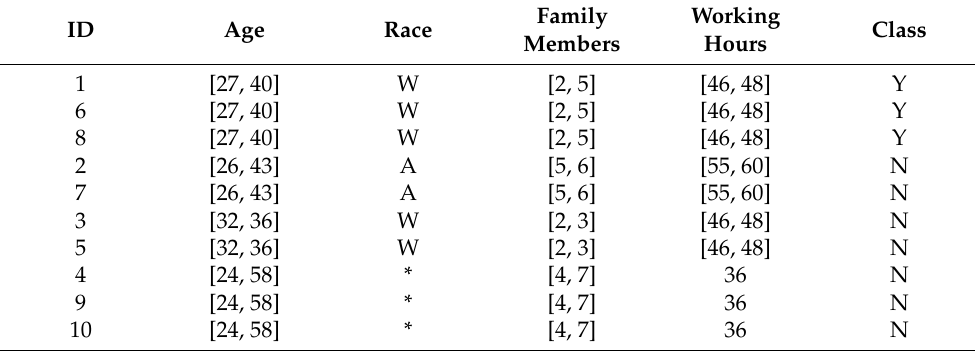
Table 3. Anonymized fragment 1 (satisfying 2-anonymity).